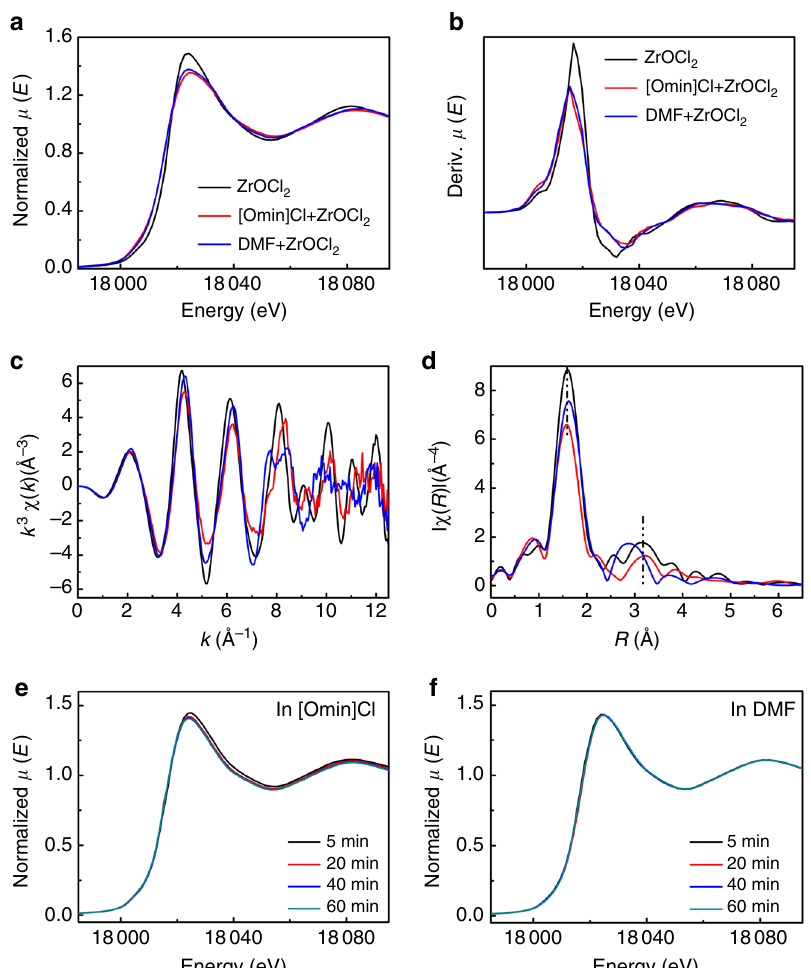
Fig. 3 XAFS spectra of ZrOCl 2 and UiO-66 synthesis mixtures. a XANES spectra of solid ZrOCl 2 · 8H 2 O and dissolved ZrOCl 2 in [Omim]Cl and DMF, respectively. b Derivated XANES spectra from A. c XANES spectra in k-space. d XANES spectra in R-space. e In situ XANES characterization for the UiO- 66 synthesis in [Omim]Cl at 298.2 K with different reaction time. f In situ XANES characterization for the UiO-66 synthesis in DMF at 298.2 K with different reaction